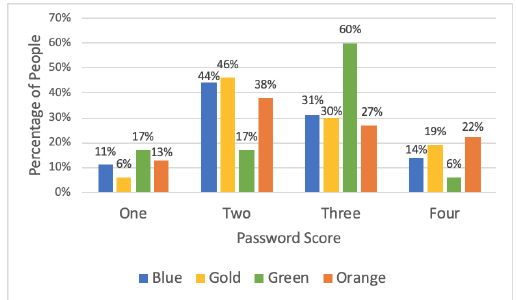
Figure 6. True Colors self schema and password strength according to